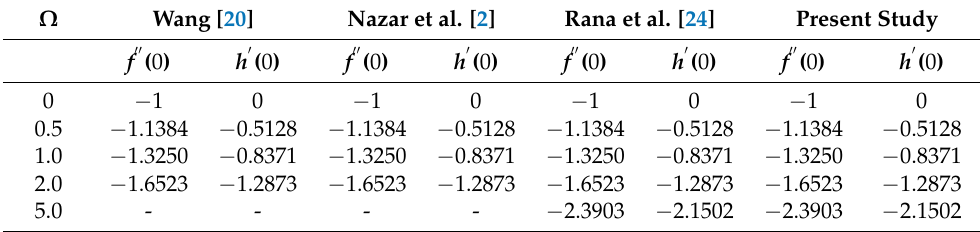
Figure 2. Variations of the skin friction coefficient in the x direction, f (cid:48)(cid:48) ( 0 ) , with stretching parameter λ for various values of φ 2 .